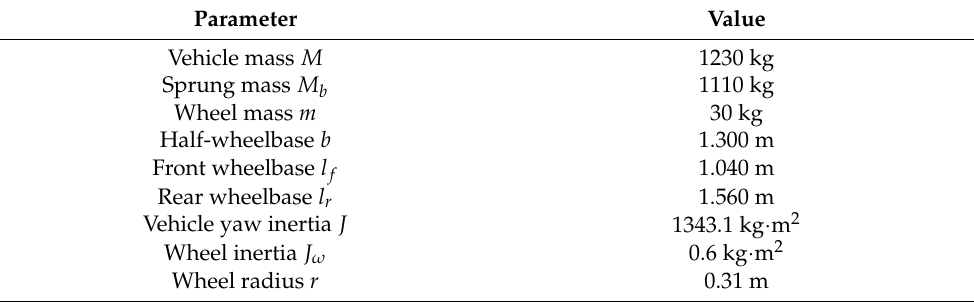
Table 1. Vehicle